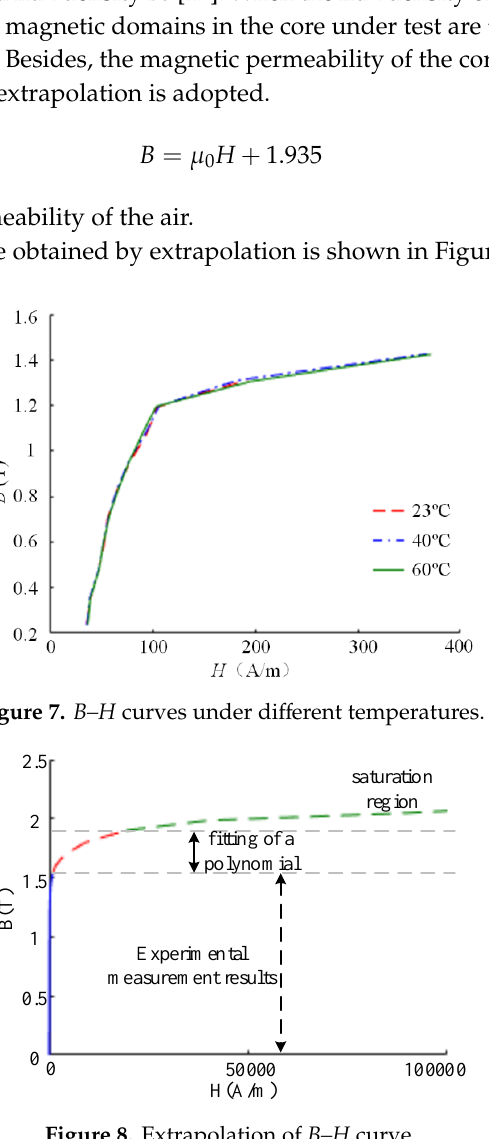
Figure 8. Extrapolation of B–H curve.